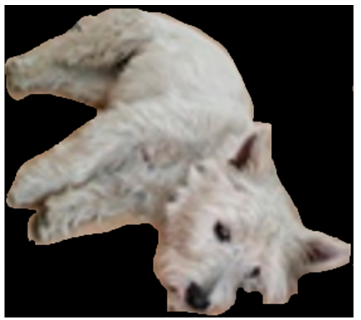
Figure 4. Background removal.